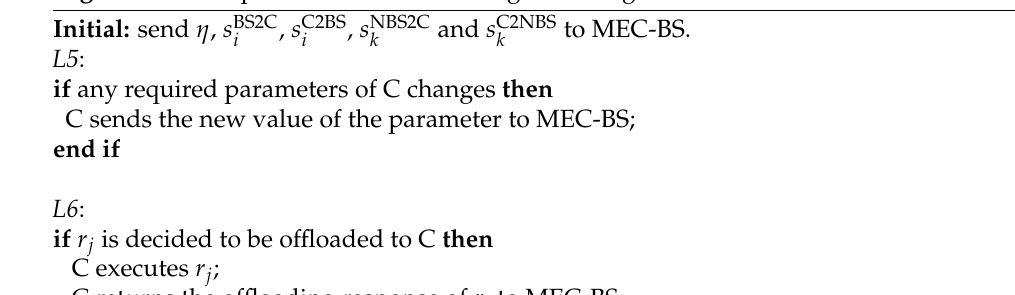
Algorithm 3 Cooperative Resource Management Algorithm at C side